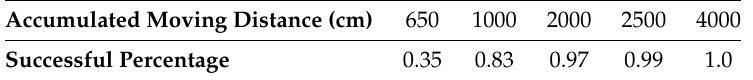
Table 3. Success percentages (the triangulation error is below 15 cm) within 1000 experiments of the proposed method for the Camera Network